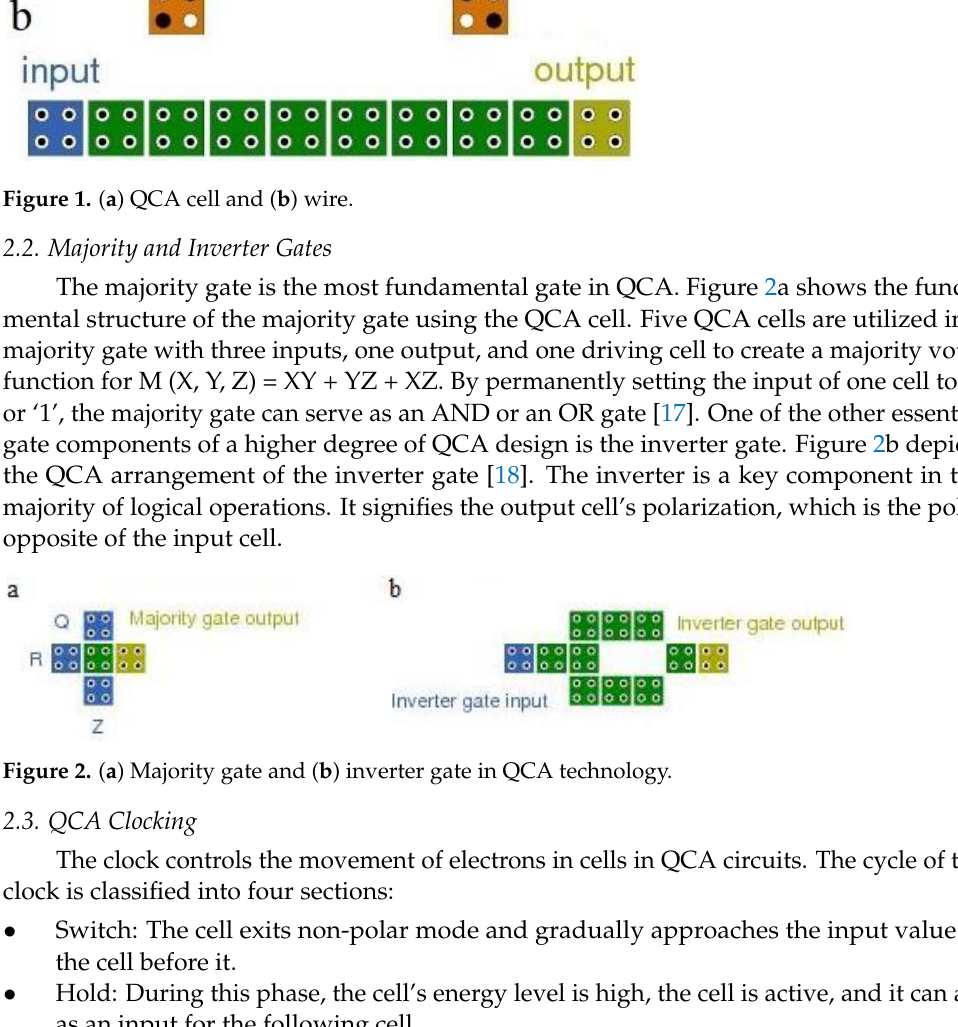
Figure 2. ( a ) Majority gate and ( b ) inverter gate in QCA technology.